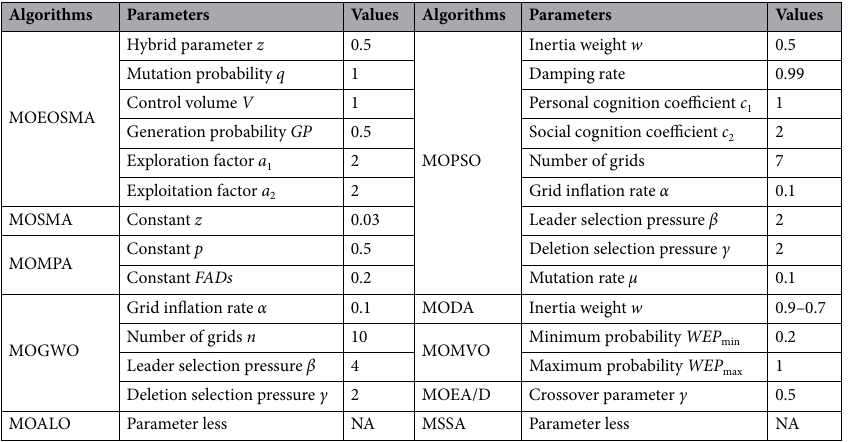
Table 4. Parameter settings of the multi-objective algorithms. For all algorithms, archive size was set to 100, N = 100, Max_t = 1000.